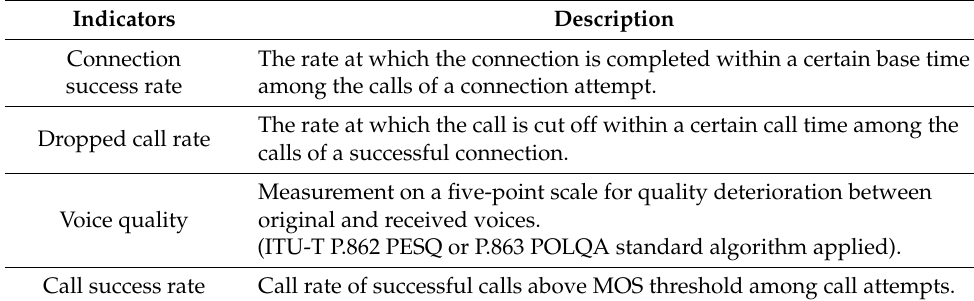
Table 6. Verification indicators for individual/group voice